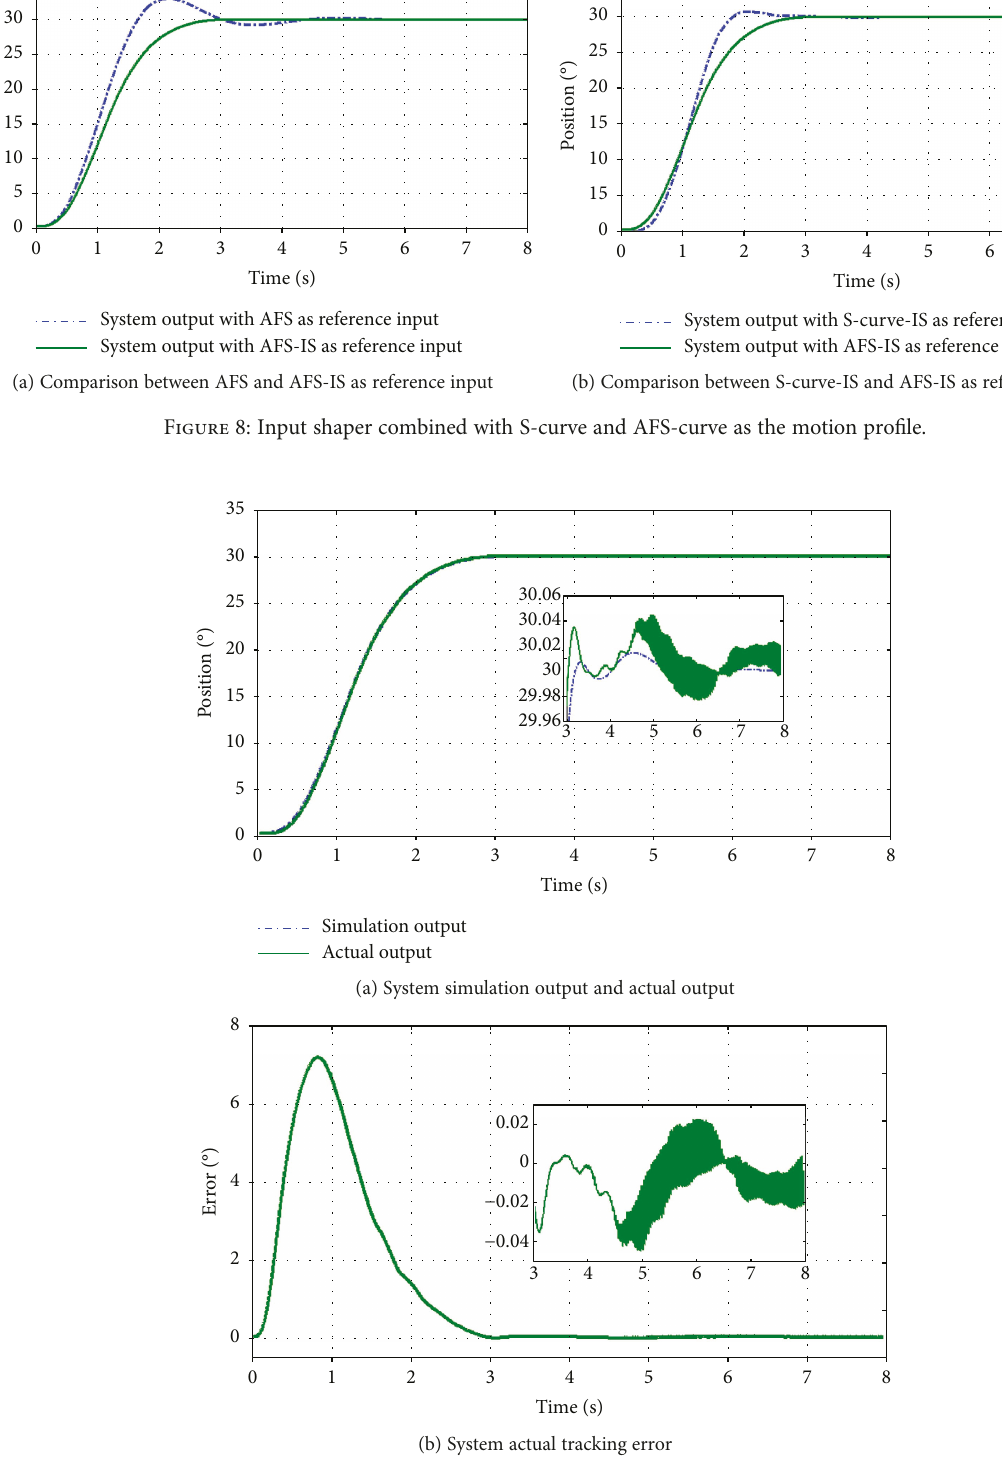
Figure 9: Actual system output and the positioning